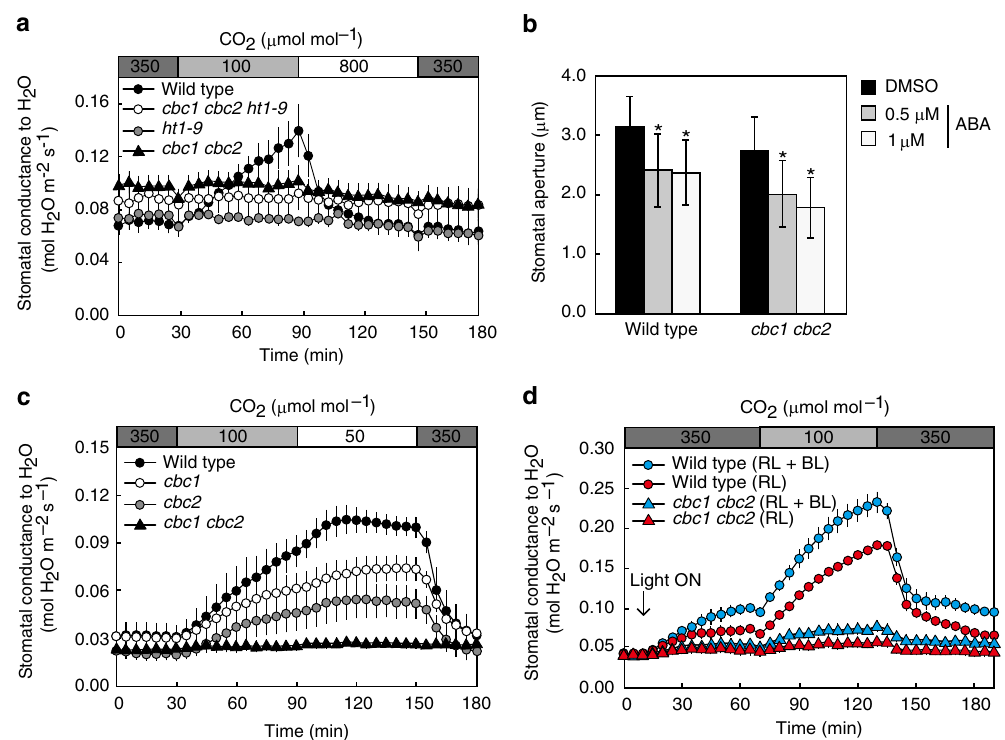
Fig. 5 Stomatal responses of the cbc mutants to CO 2 and ABA in Arabidopsis . a Stomatal movements of the cbc1 cbc2 , ht1-9 , and cbc1 cbc2 ht1-9 mutants in response to changes in CO 2 concentration in the dark. b Stomatal closure mediated by ABA in cbc1 cbc2 . c Stomatal responses of the cbc1 , cbc2 single mutants and the cbc1 cbc2 double mutant in response to changes in CO 2 concentration in the dark. d Stomatal conductance increases in WT plants and the cbc1 cbc2 double mutant in response to the CO μ mol m − 2 s − 1 ) plus BL (10 μ mol m − 2 s − 1 ) or RL 2 concentration decrease under the moderate light of RL (90 (100 μ mol m − 2 s − 1 ) only. The CO 2 concentration was changed as indicated. a , c , d Bars represent ± s.e.m. ( n = 4 for a , c and n = 8 for d ). Stomatal opening in intact leaves was induced by light, and the epidermal peels were obtained. b ABA was added to the peels at the indicated concentrations and kept in the light for 2 h. Experiments were repeated three times in different occasions. Bars represent means ± s.d. ( n = WT. The results indicate that CBC1 and CBC2 are required for